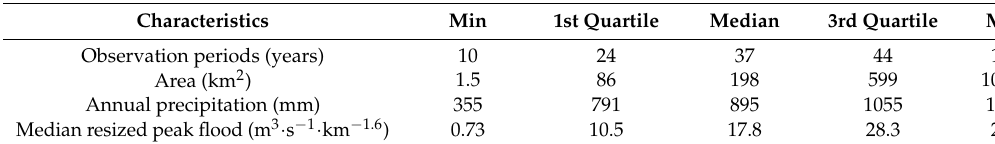
Table 1 . Characteristics of the catchment set. Table 1. Characteristics of the catchment set.